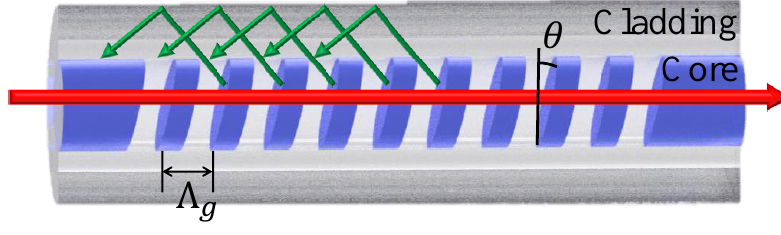
Figure 1. Schematic diagram of TFBG.